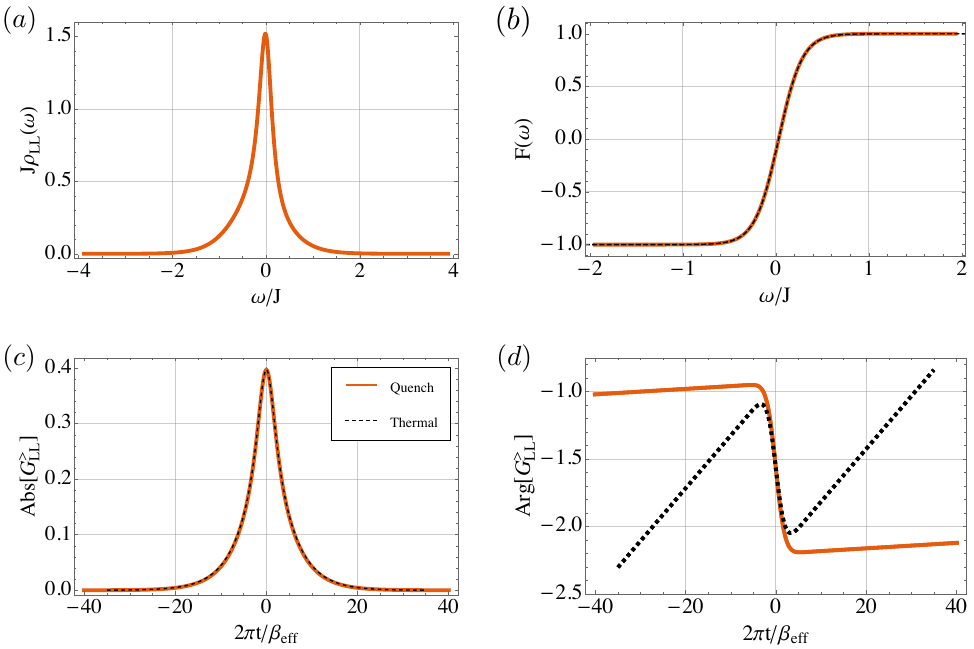
Figure 6 . (a). The spectral function ρ LL ( ω ) in the long time limit for turning off µ c . (b). The quantum distribution F ( ω ) in the long time limit for turning off µ c . The dashed line represents the fitting with F ( ω ) = tanh (3 . 95( ω/J − 0 . 029)) , which gives a final state with β eff J = 7 . 9 and µ 0 /J = 0 . 129 . We then compare the thermal real-time Green’s function and the quench result in (c) and (d), with only a phase difference due to δµ , as predicted by (2.48). form as